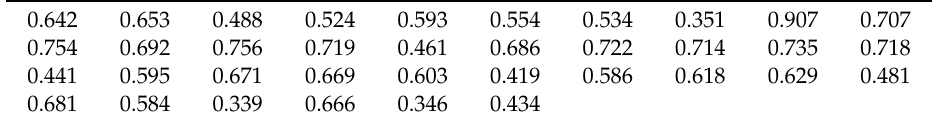
Table 5. Values of correlation coefficients (minimum redundancy: Feature vs. feature), WBC